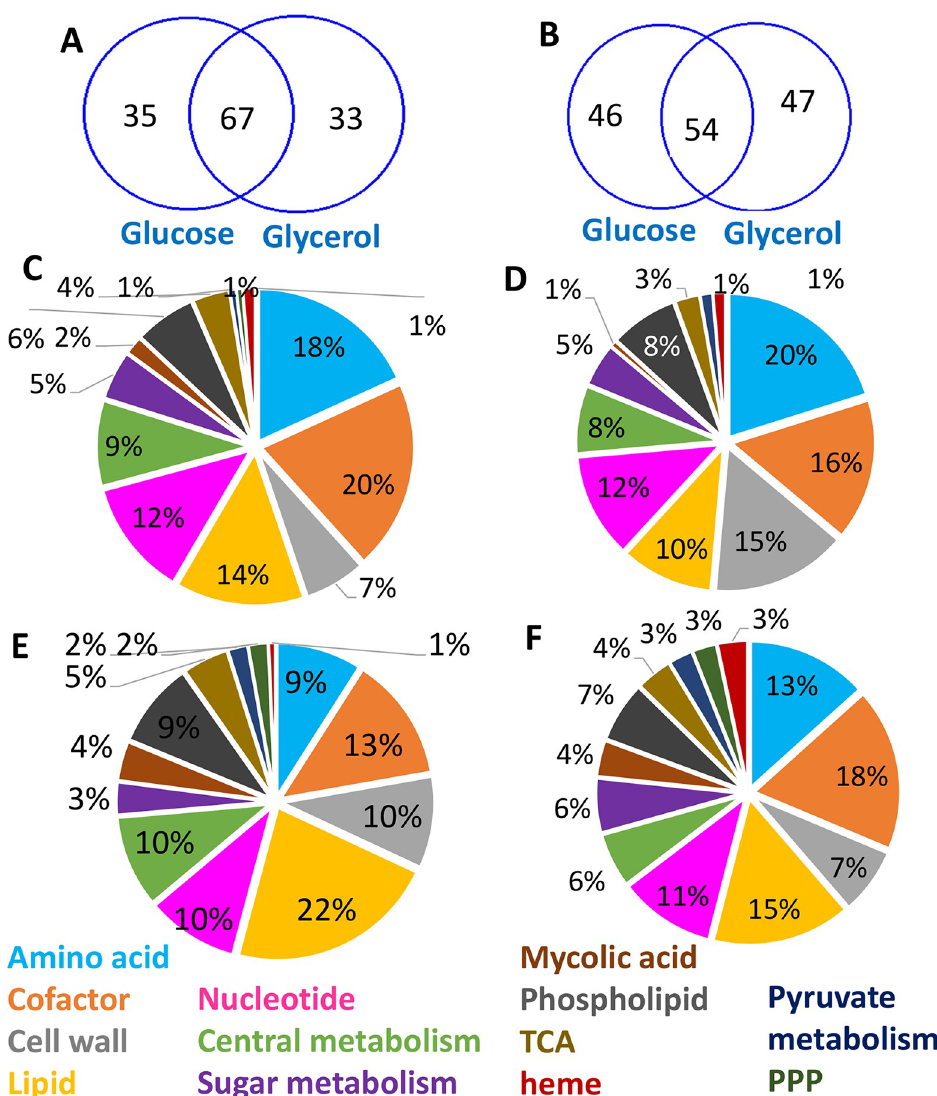
Fig 3. DPA analysis of gene expression patterns to identify metabolic processes associated with up-regulated (A) and down-regulated M . leprae genes (B) in vivo . Venn diagram compares metabolites identified as associated with up-regulated (C and D) or down-regulated (E and F) genes using either glucose (C and E) or glycerol (D and F) as carbon source in DPA.